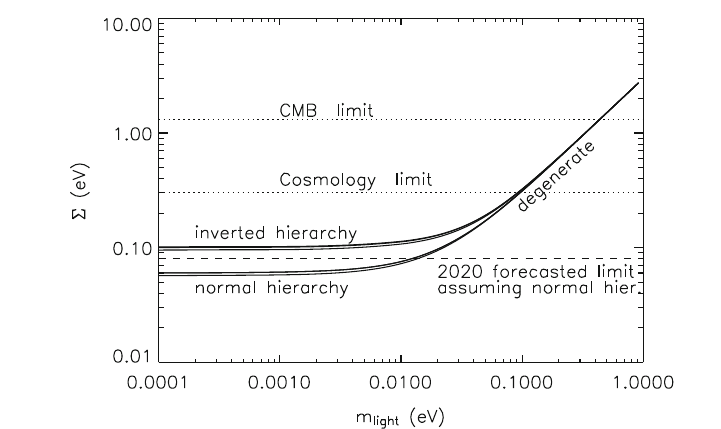
Fig. 41 Constraints from neutrino oscillations and from cosmology in the m – Σ plane. Image reproduced by permission from Jiménez et al. (2010); copyright by IOP and SISSA